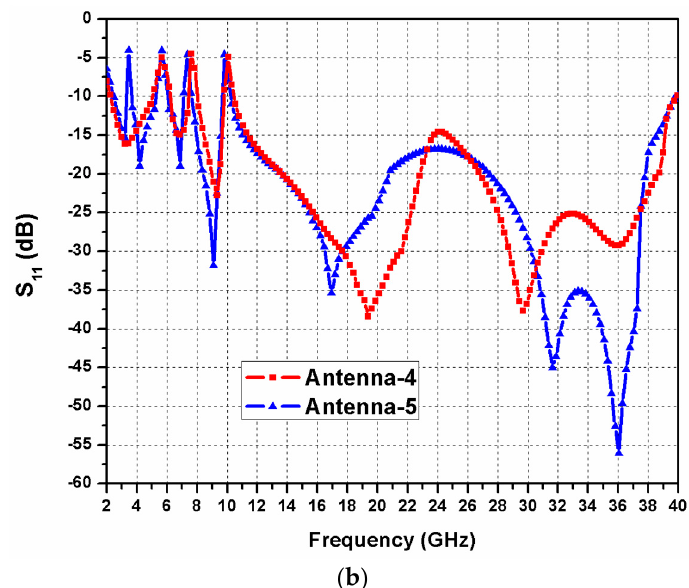
Figure 3. S 11 of the proposed antenna design steps: ( a ) Antenna-1 to -3; ( b ) Antenna-4 to -5.